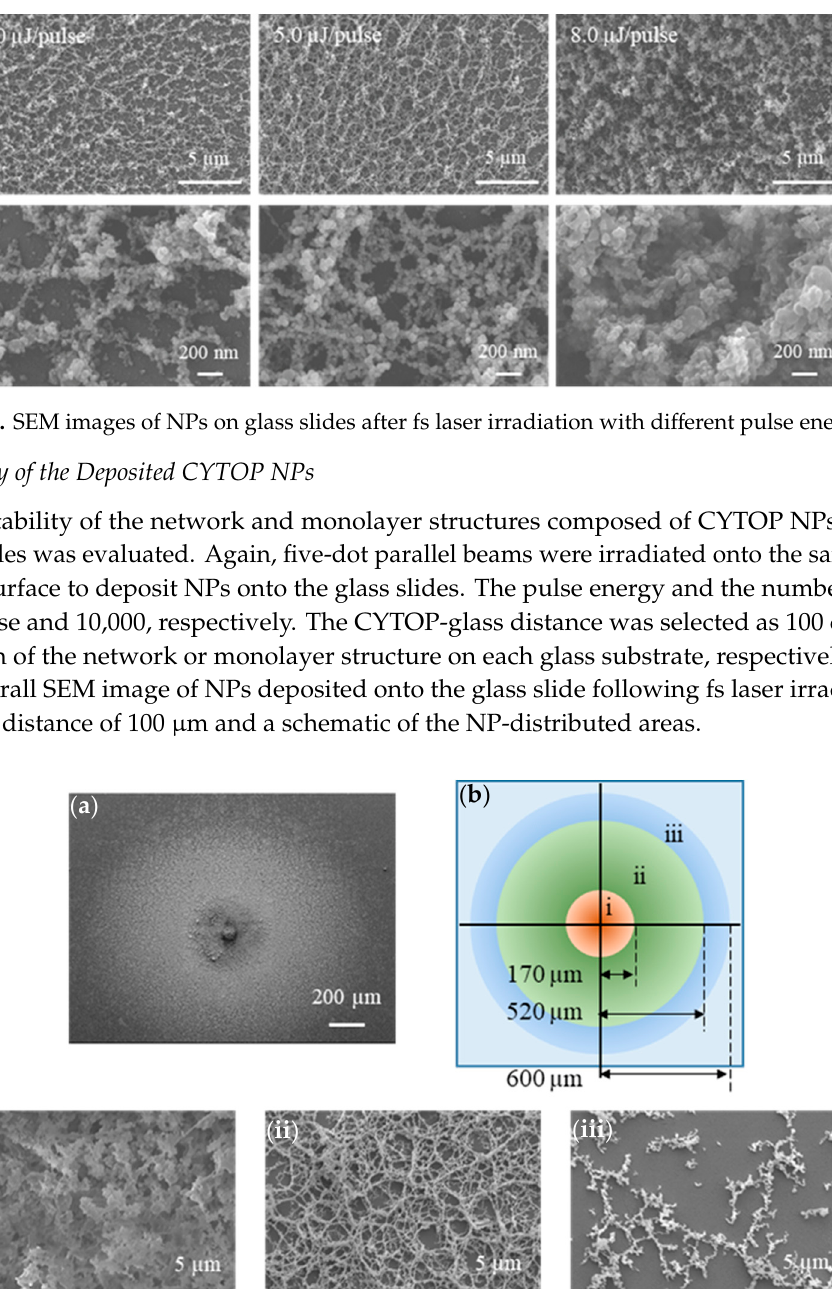
Figure 6. ( a ) Overall SEM image of deposited NPs on the glass and ( b ) a schematic of the NP- distributed areas. ( i – iii ) Enlarged SEM images corresponding to NPs deposited in areas i–iii in subfigure (b).